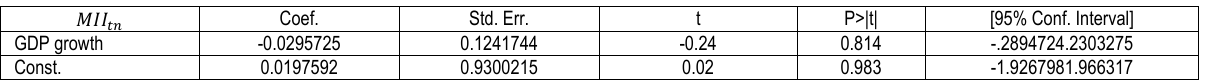
Figure 1. Macroeconomic instability index and economic growth of Ukraine during 1995 ‒2 015 (own calculations based on Eurostat data) Table 4. Linear regression of the macroeconomic instability index ( ) and proper value of GDP growth of Ukraine during 1995 ‒2 015 (own calculations based on Eurostat data) 𝑀𝐼𝐼 𝑡𝑛